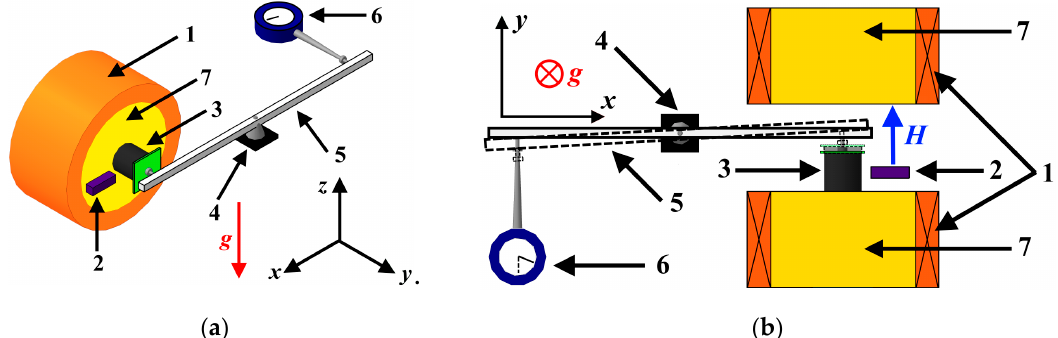
Figure 1. Schematic diagram of the experimental setup for measuring the extensional strain of MAE cylinders: ( a ) three-dimensional view; and ( b ) top view. (1) Electromagnetic coils; (2) Magnetic field sensor; (3) MAE cylinder; (4) pivot point with bearings on a stand; (5) non-magnetic lever; (6) digital indicator with a shaft; and (7) electromagnet poles. The magnetically soft iron yoke is not drawn for clarity of the figures. g denotes the gravity vector.